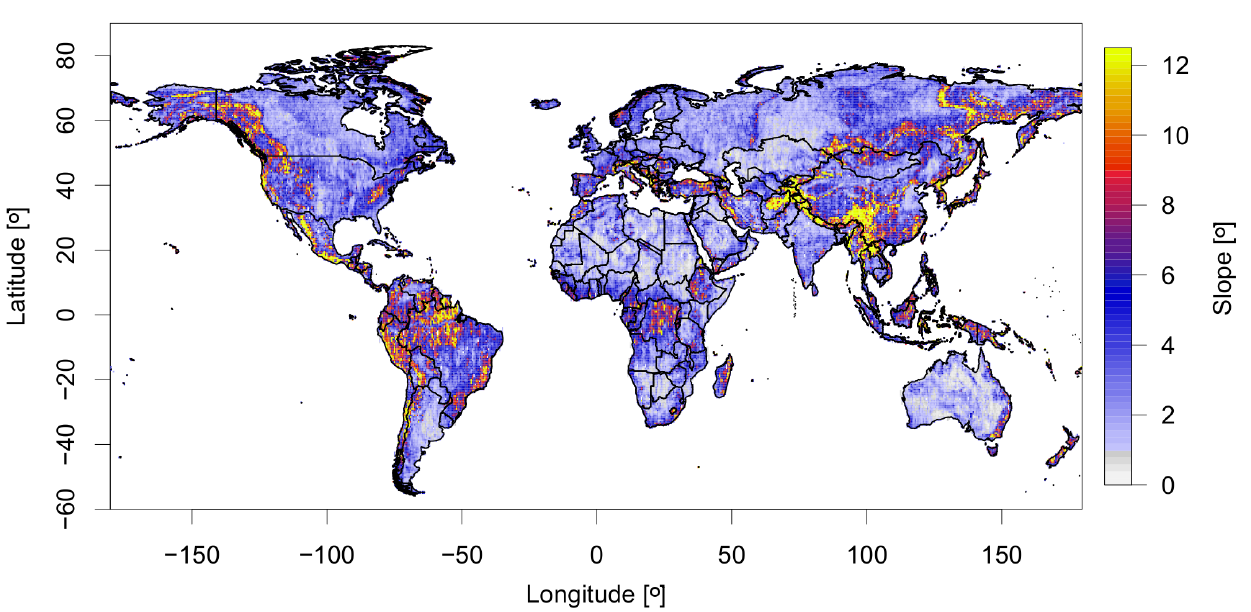
Figure 8. Near global ISM product based on histogram weighted mean values at a spatial resolution grid of 0 . 5 ◦ × 0 . 5 ◦